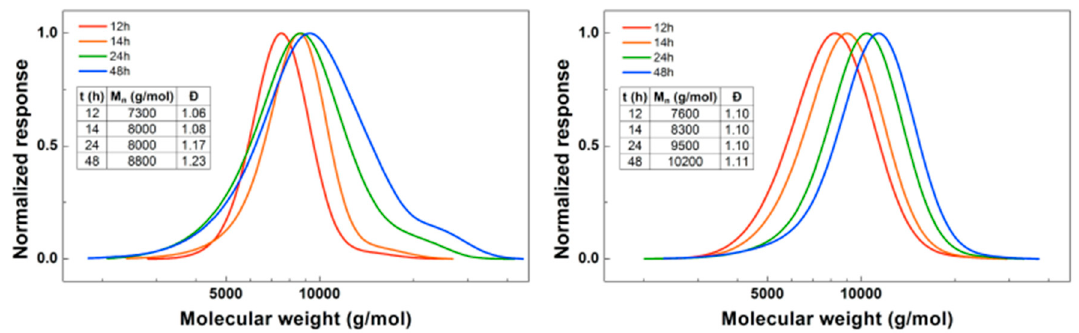
Figure 3. ( Left ): SEC traces for PBA- b -PDMAEA using EBP as initiator. ( Right ): SEC traces for PBA- b -PDMAEA using ECP as initiator.